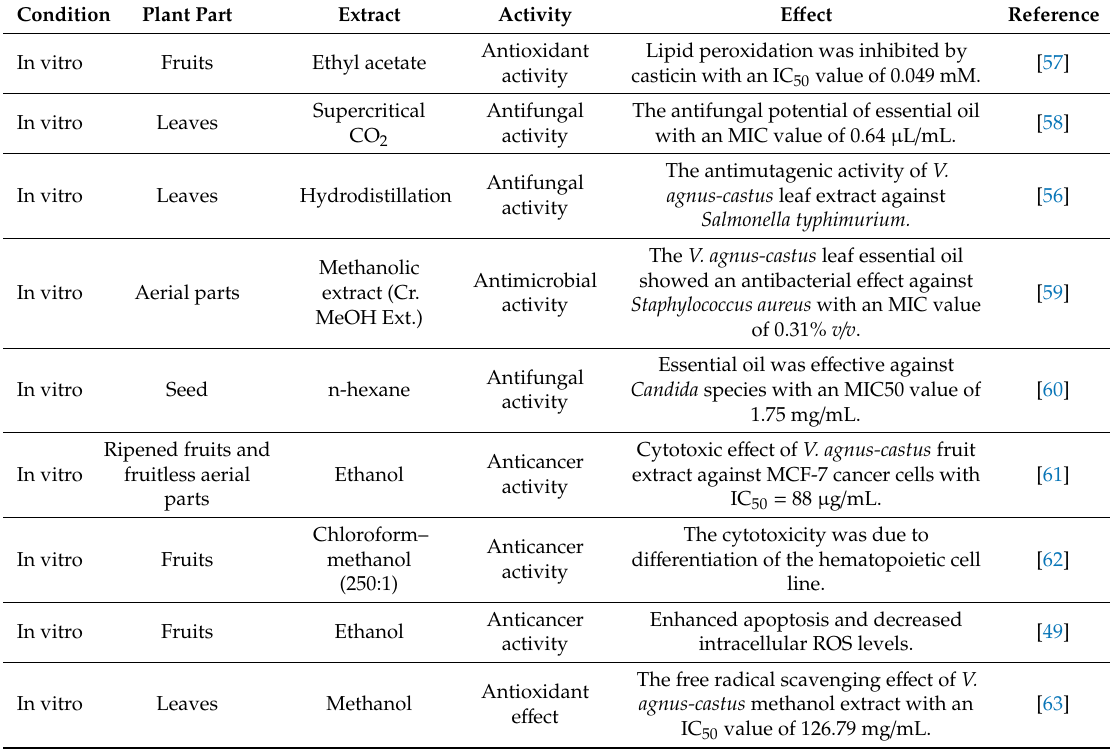
Table 1. In vitro reported activities for V. agnus-castus